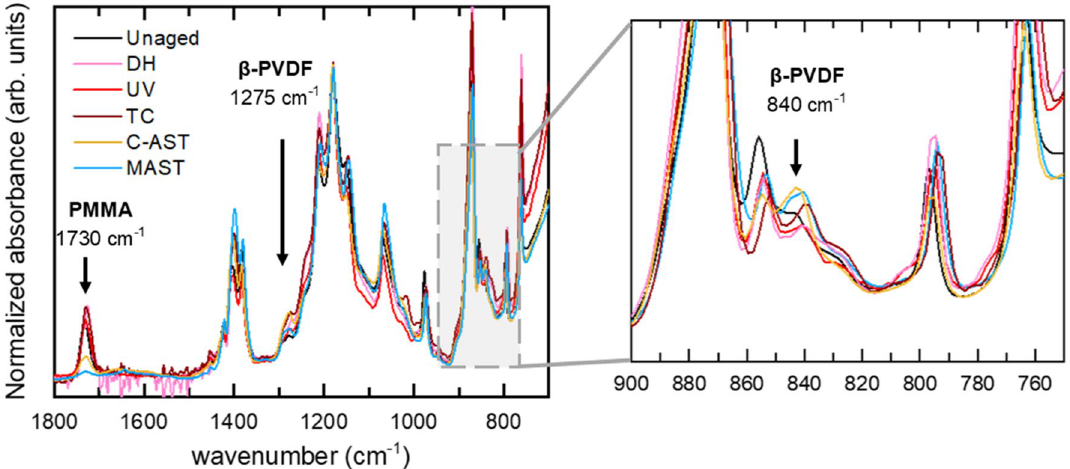
Figure 2. Normalized FTIR spectra of the weathering-exposed surface of the single-layer PVDF-A. Labelled peaks are specific to the PMMA polymer and β-PVDF phase; other sharp unlabeled peaks are from PVDF peaks common to all phases or exclusive to α-PVDF. The inset on the right shows the detail in the region of 900–750 cm −1 containing the second β-PVDF FTIR